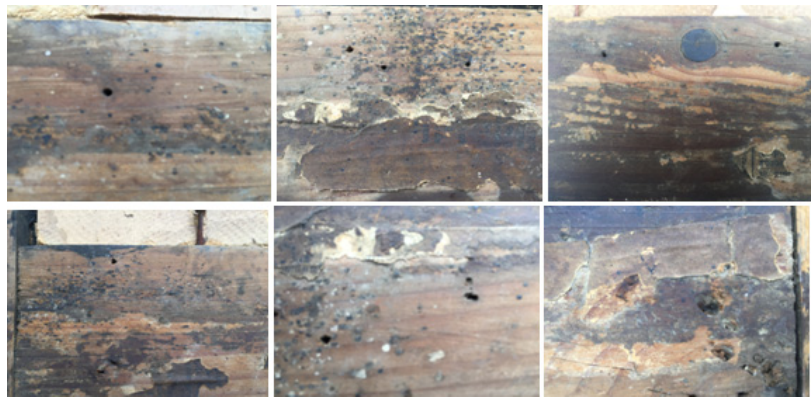
Figure 13. Flight galleries of xylophagous insects and other deterioration and degradation of back of the frame.